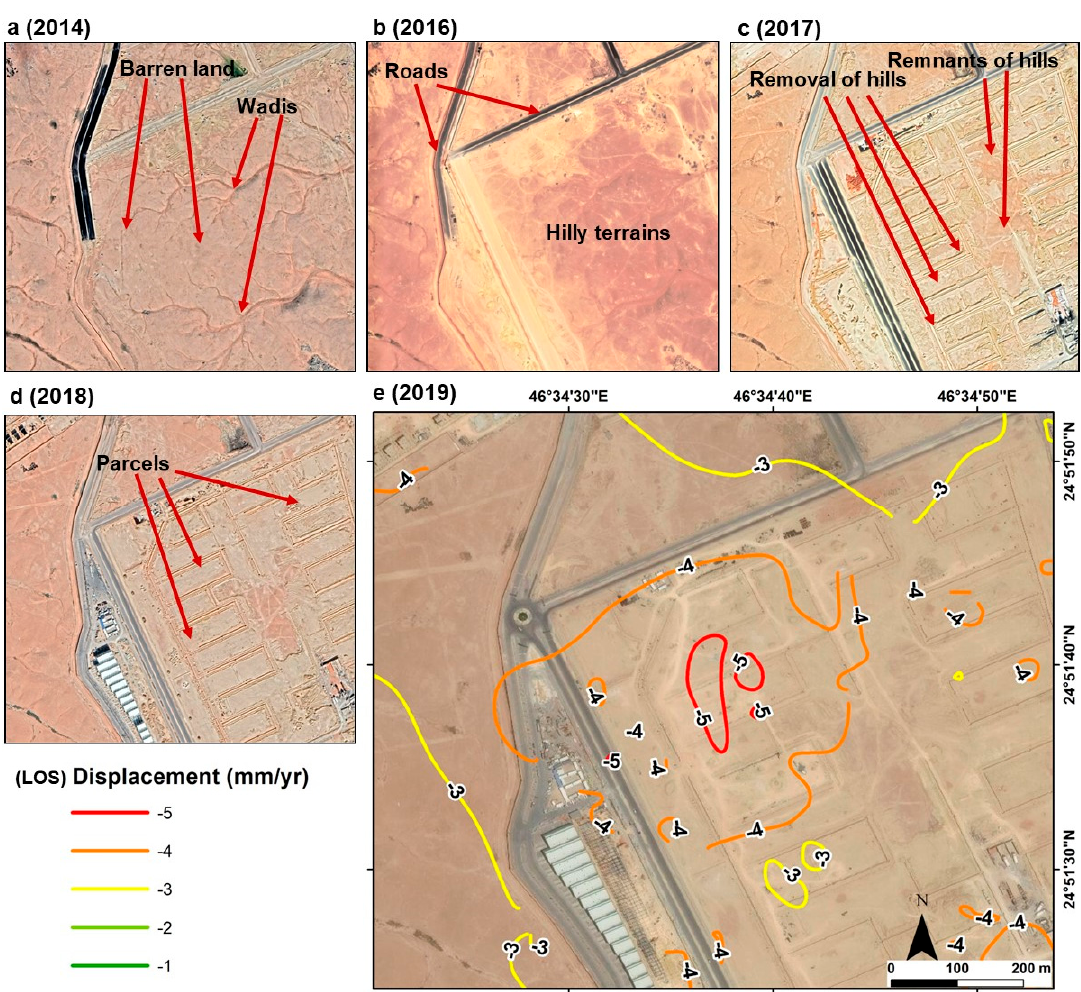
Figure 9. Temporal Google Earth images (2014 to 2018), ArcGIS online base map (2019), and LOS velocities over karstic limestone (site K1) in Al Qirawan District. ( a ) Google Earth image acquired in January 2014. ( b ) Google Earth image acquired in March 2016. ( c ) Google Earth image acquired in December 2017. ( d ) Google Earth image acquired in December 2018. ( e ) LOS deformation rates plotted over the 2019 ArcGIS online base map.